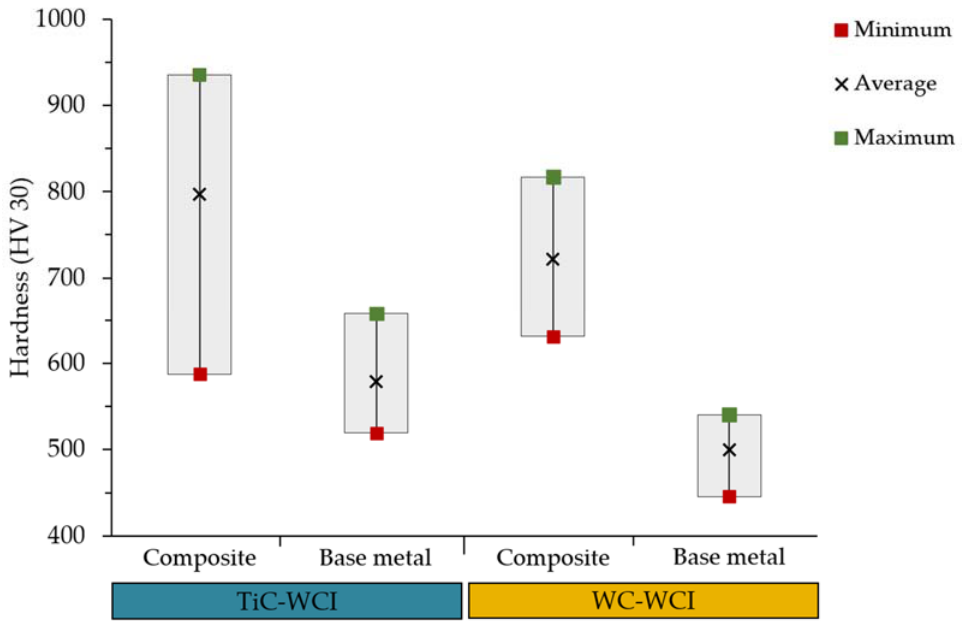
Figure 6. Comparison of the hardness between the base metal and the reinforcements produced.